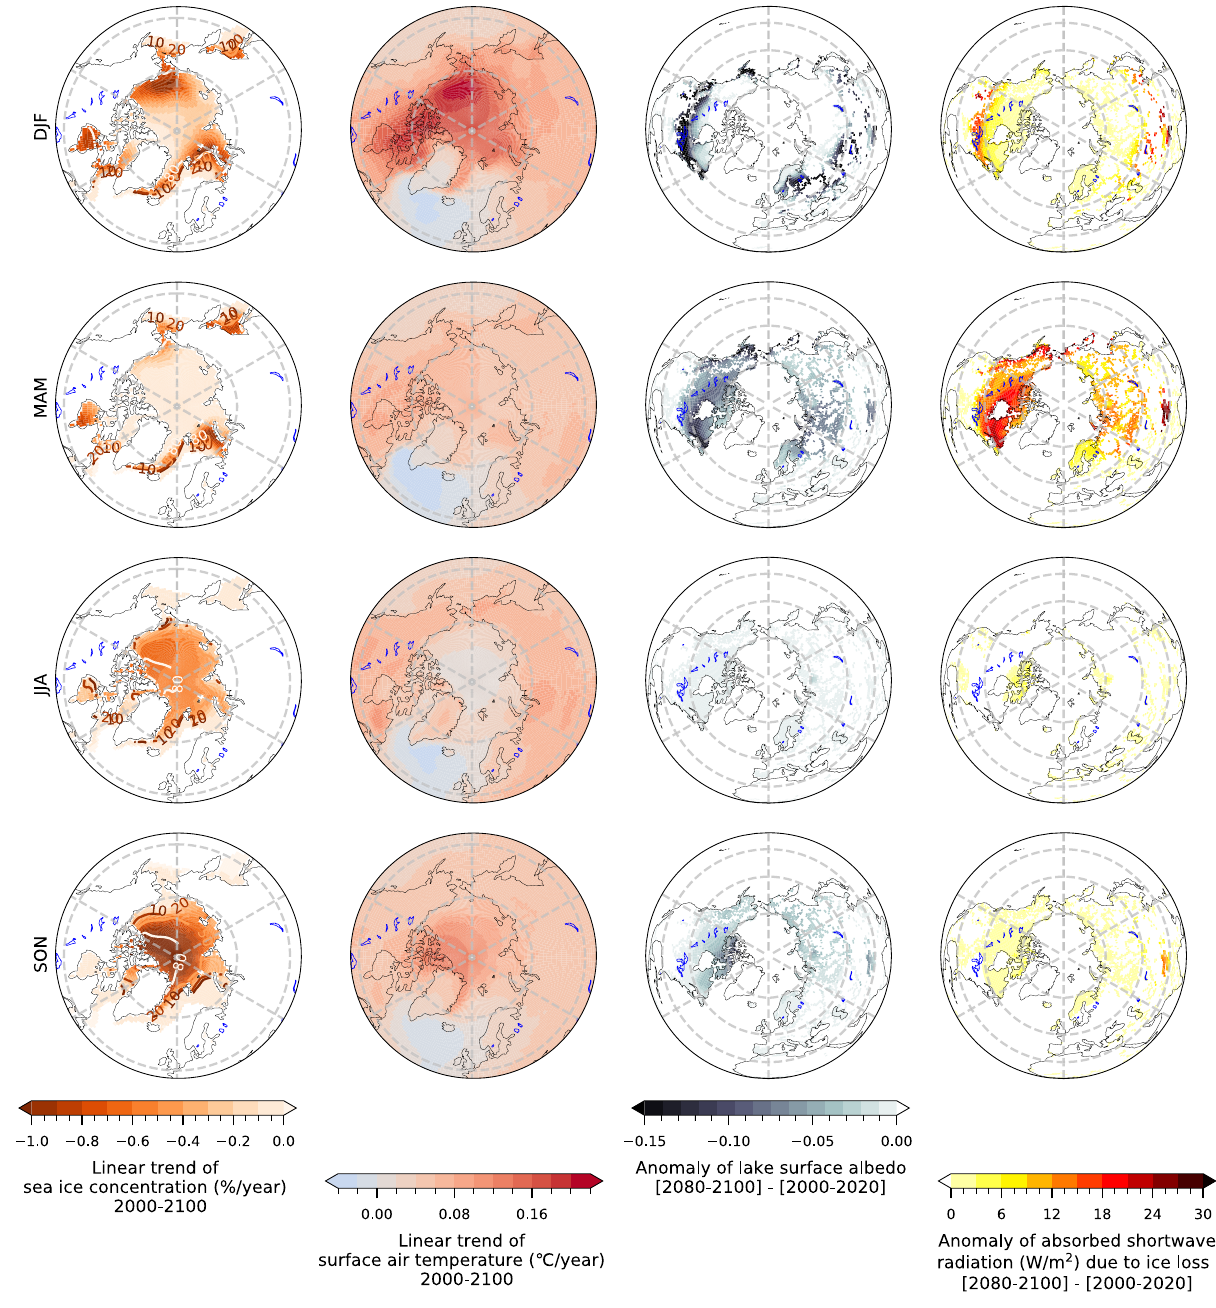
Fig.3|Driversoflakeiceloss. SeasonallineartrendofArcticsea-iceconcentration ( fi rst left column, unit: %/year) and surface air temperature changes (second col- umn, unit: °C/year) in 2000 – 2100. Changes (climatological mean of 2080 – 2100 minus climatological mean of 2000 – 2020) of lake surface albedo (third column) and absorbed shortwave radiation (fourth column, unit: W/m 2 ) by